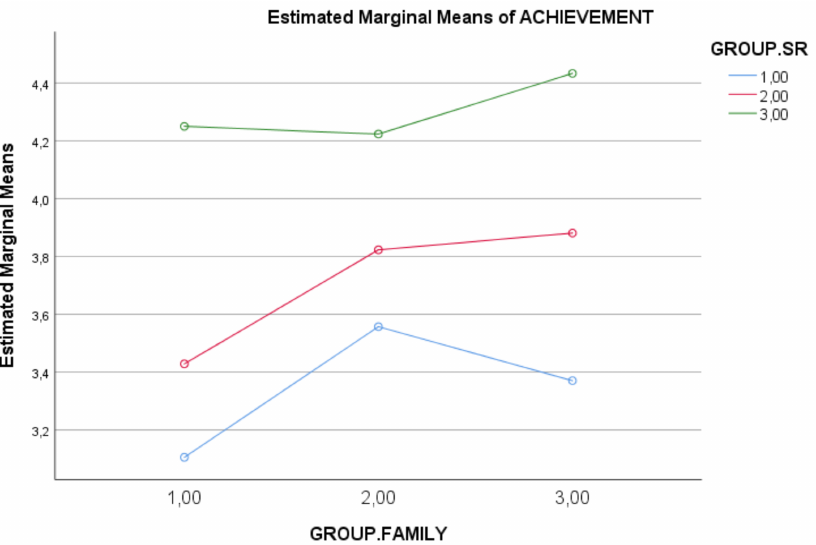
Figure 2. Self-regulation students level (GROUP.SR; 1.00 = Low; 2.00 = Medium; 3.00 = High) and socio-educative family level (GROUP.FAMILY; 1.00 = Low; 2.00 = Medium; 3.00 = High) effects on the adolescent’s academic